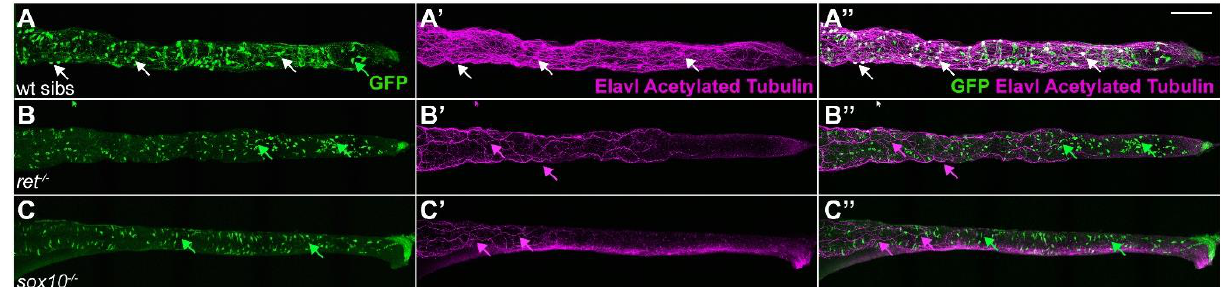
Figure 7. ret and sox10 mutants lack GFP + ENS cells. ( A – A’’ ) In 6 dpf wildtype siblings (wt sibs), GFP + cells colocalize with the pan-neuronal markers Elavl and acetylated Tubulin (AT, white arrows) in ENS neurons; Elavl − /AT − /GFP + cells with a characteristic teardrop shape are enteroendocrine cells (green arrow). In 6 dpf ret ( B – B’’ ) or sox10 ( C – C’’ ) homozygous mutants, GFP + ENS neurons are absent. AT + processes are the vagal innervation to the gut (magenta arrows). Elavl − /AT − /GFP + enteroendocrine cells are still present (green arrows). We analyzed ≥30 larvae per genotype. ( A – C ), maximum projections of dissected guts. Scale bar = 100 µm.